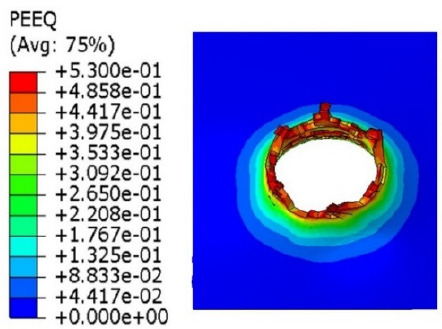
Figure 23. PEEQ visualization for two layers of titanium alloy.